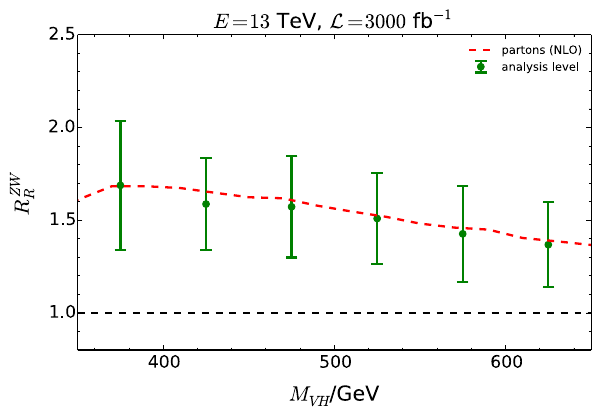
Fig. 10 The double ratio R ZW is shown in green error bars, assuming R SM gg → ZH (wherewehaveappliedaglobal K -factorof K = 2).The sizeoferrorbarsindicatesthetotaltheoreticalandstatisticaluncertainty as given by Eq.(9). The red dashed line shows the inclusive double ratio at parton level, including the parton